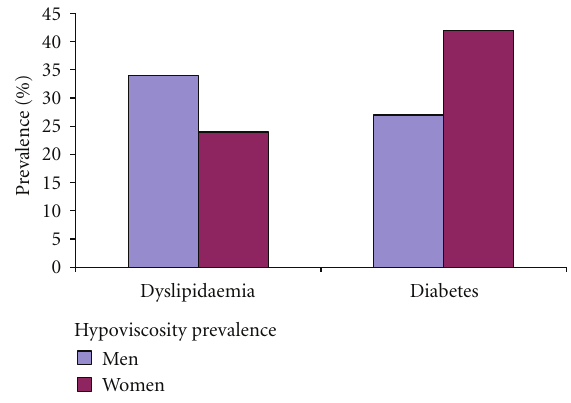
Figure 4: Prevalence of hypoviscosity in anemic diabetes and